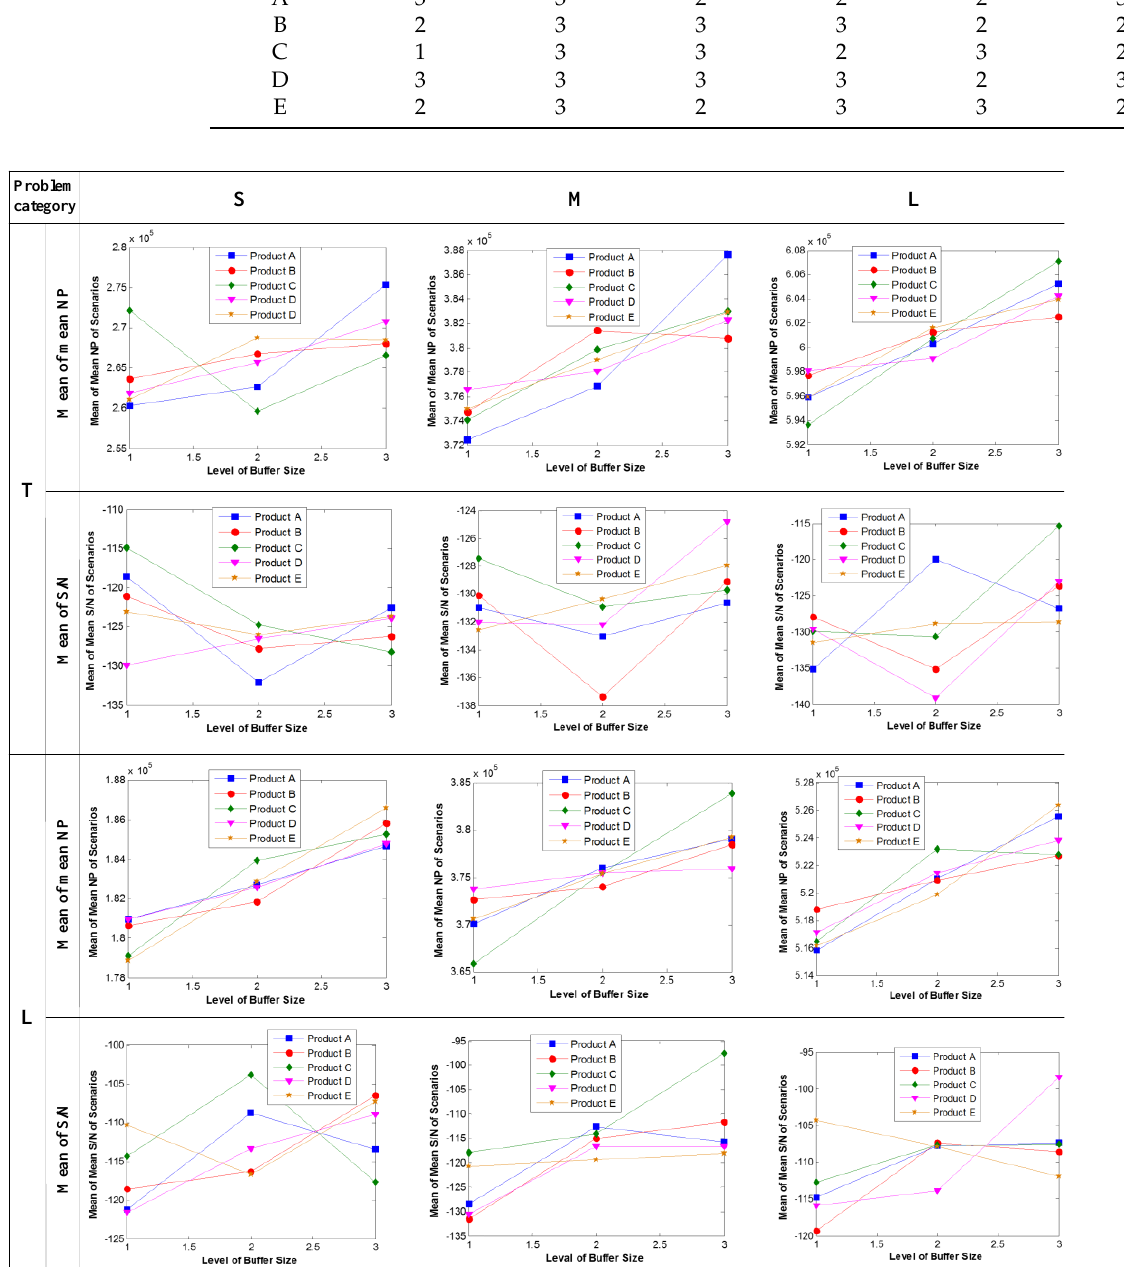
Figure 7. Mean of mean NP and mean of mean S/N of scenarios against levels of buffer size for TS, TM, TL, LS, LM, and LL problems.